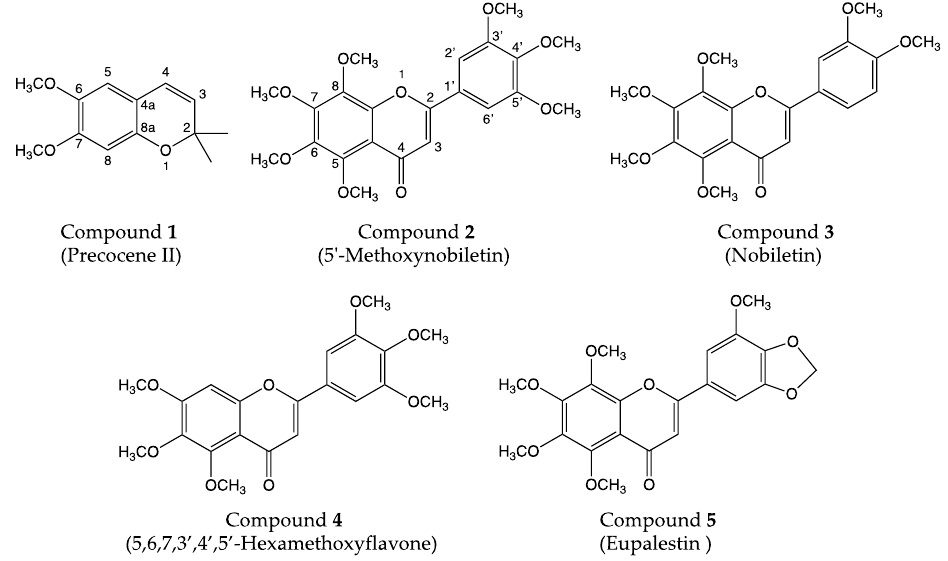
Figure 3. Chemical structures of antifungal compounds 1 – 5 isolated from ACE. The chemical structures of the compounds were determined using ESI-TOF MS and NMR spectroscopy. Compound 1 , precocene II; compound 2 , 5′ -methoxynobiletin; compound 3 , nobiletin; compound 4 , 5,6,7,3 ′ ,4 ′ ,5 ′ - hexamethoxyflavone; compound 5 ,